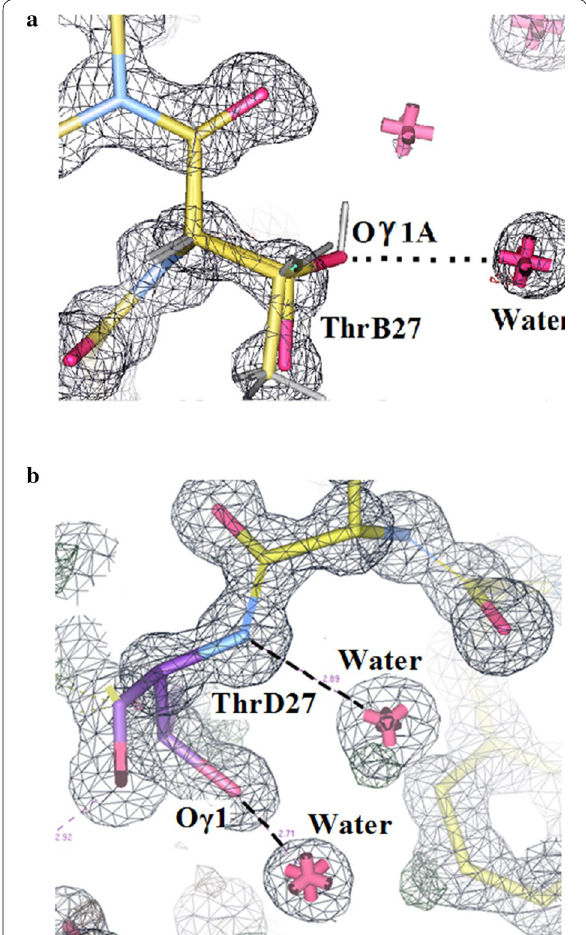
Fig. 18 a Insugen (I) HR insulin: WINCOOT 0.7 [19] electron density in the vicinity of ThrB27 in chain B. Unlike the corresponding site ThrD27 in chain D there is no evidence of solvated propanol in this site. b Intergen (II) 3W7Y: WINCOOT 0.7 [19] electron density in the vicinity of Thr D27. There is no evidence of solvated propanol in this site. The same applies to the Intergen (II) ThrB27